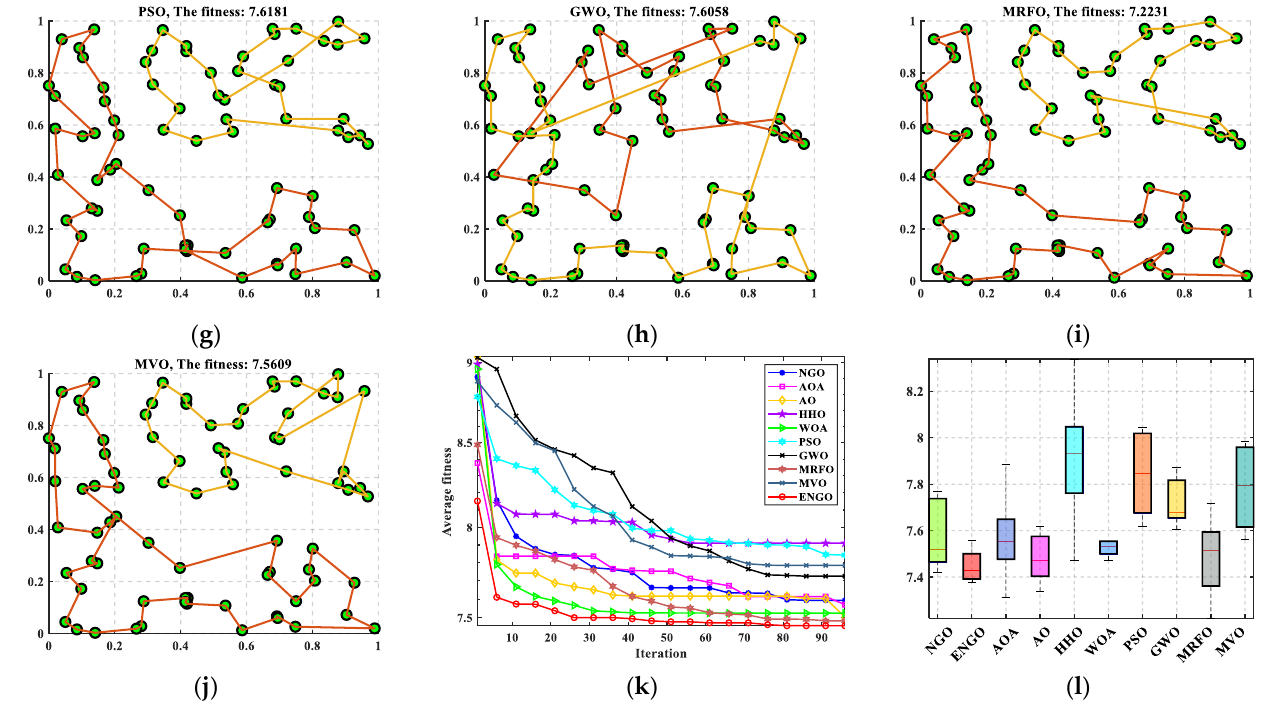
Figure 13. The best results, the convergence and box plot of all algorithms for the TSP with 80 cities and two traveling salesmen. ( a ) NGO; ( b ) ENGO; ( c ) AOA; ( d ) AO; ( e ) HHO; ( f ) WOA; ( g ) PSO; ( h ) GWO; ( i ) MRFO; ( j ) MVO; ( k ) The convergence curve; ( l ) The box plot.